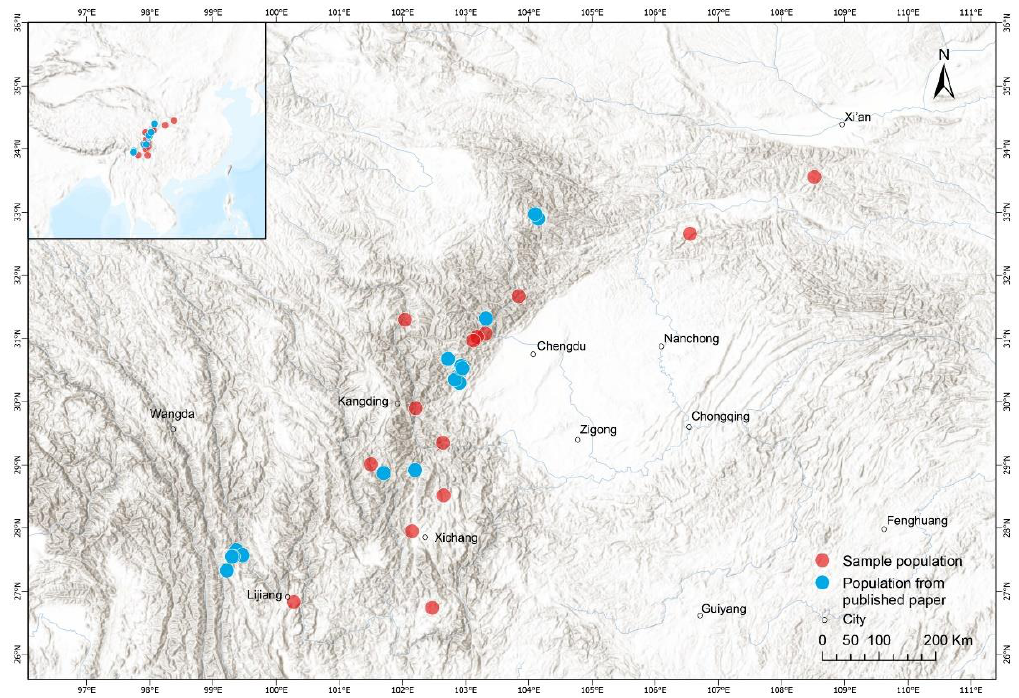
Figure 1. Geographic distribution of the studied populations for B. andrewsi at Hengduan Mountains in western China.